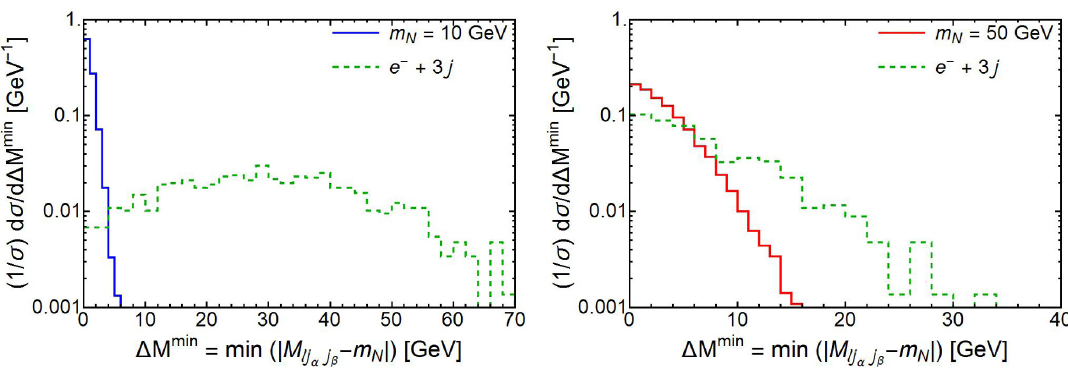
Figure 5 . ∆ M min distributions for m N = 10 (50) GeV along with the same for the e − + 3 j backgrounds, after applying the cuts of eq.